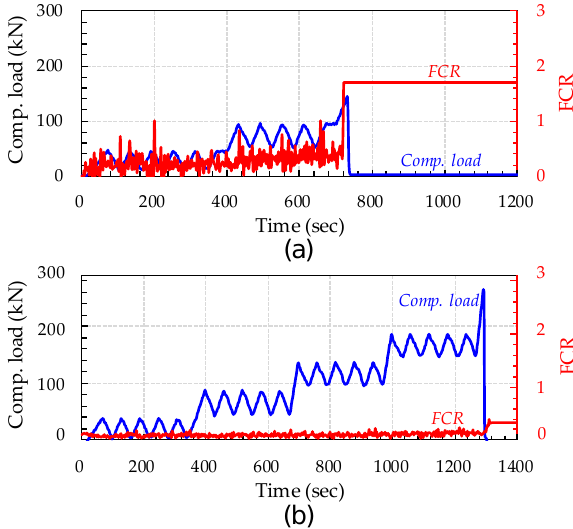
Figure 5. Comparative load–time and FCR–time curves of UHPFRC with 3% steel fibers: ( a ) V-series; and ( b ) H-series (Note: V, copper plates vertical to casting direction; and H, copper plates horizontal to casting direction).